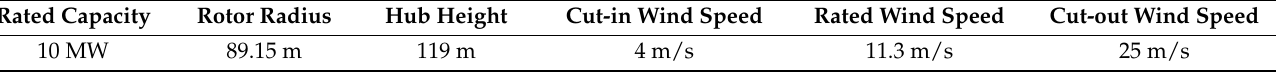
Table 1. Parameters of the wind turbine.